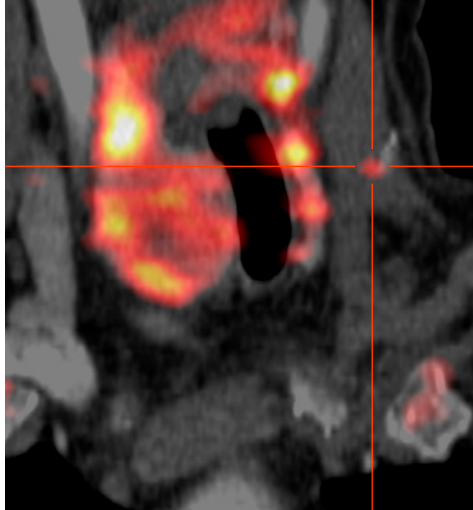
Figure 1. Autotransplanted tissue of a parathyroid adenoma, 18 years after initial surgery depicted by FEC-PET-CT-scan and localized into the left sternocleidoid muscle next to a clip. To the right of the trachea, the right thyroid lobe is seen and to the left of the trachea a chain of parathyroid adenomata, caused by parathyreomatosis is noted.